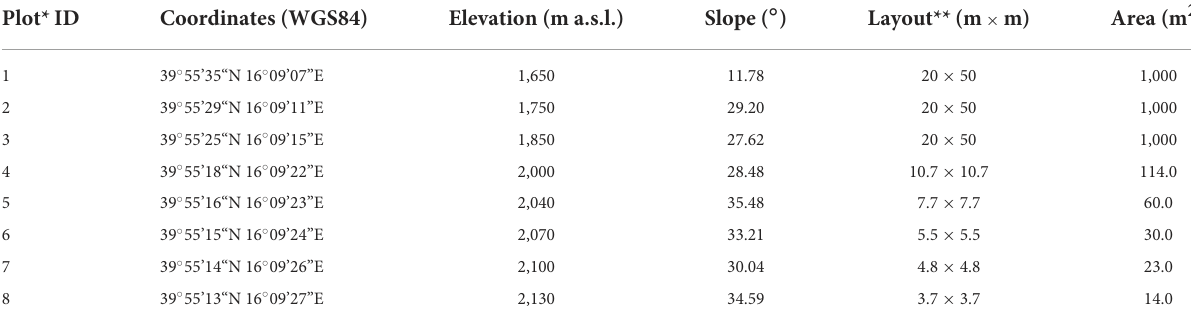
TABLE 1 Geographic coordinates, elevation, layout, and size of sampling